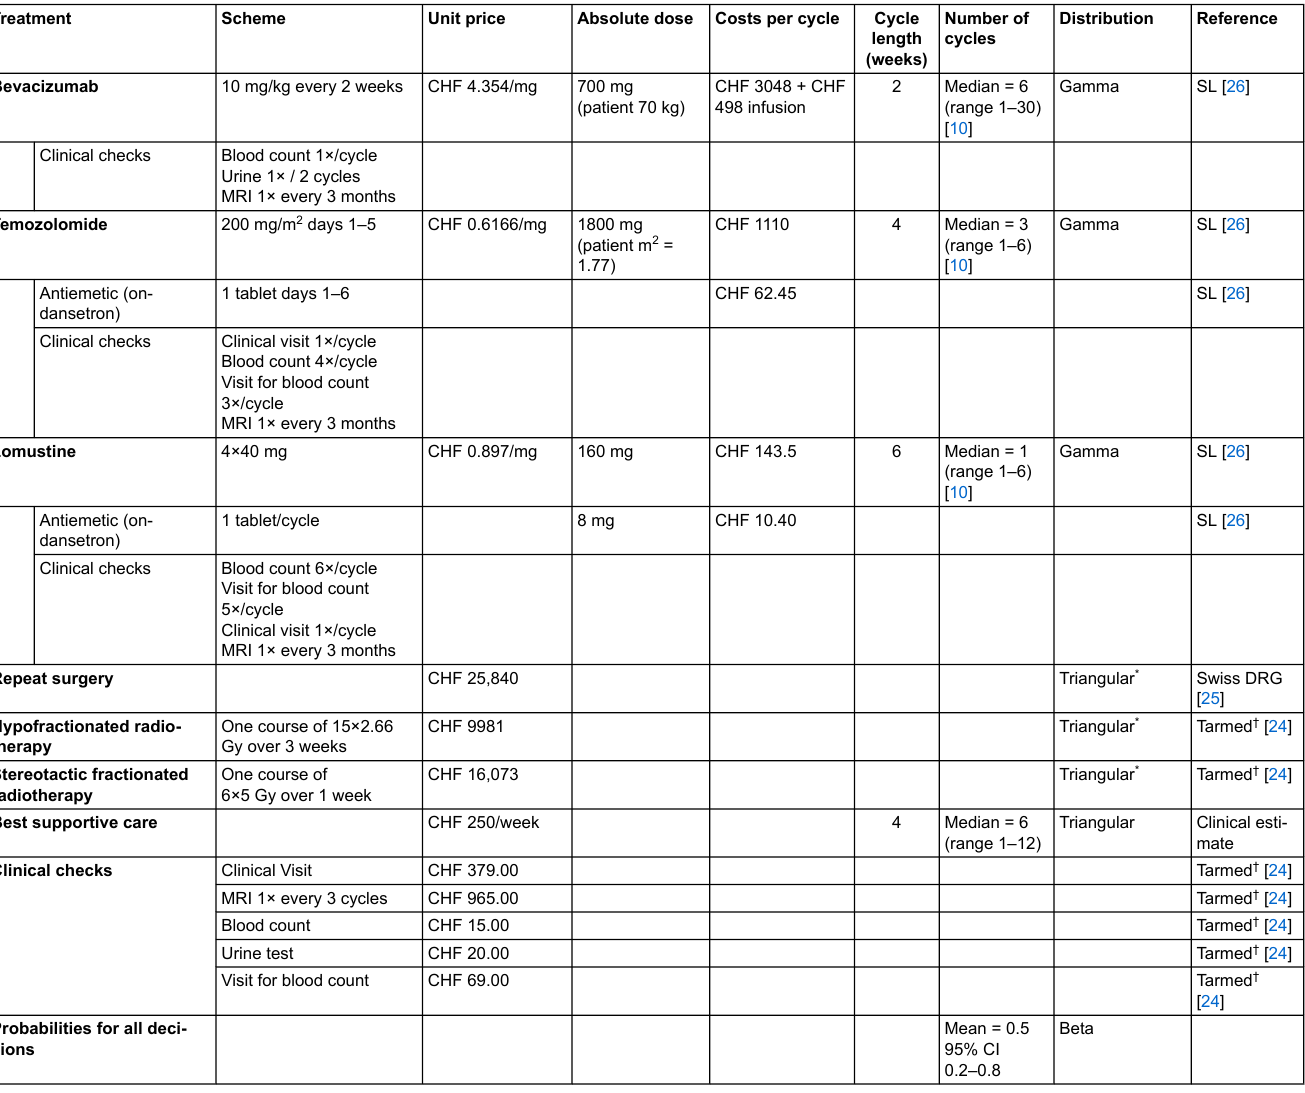
Table 1: Costs, treatment duration and decision probability input